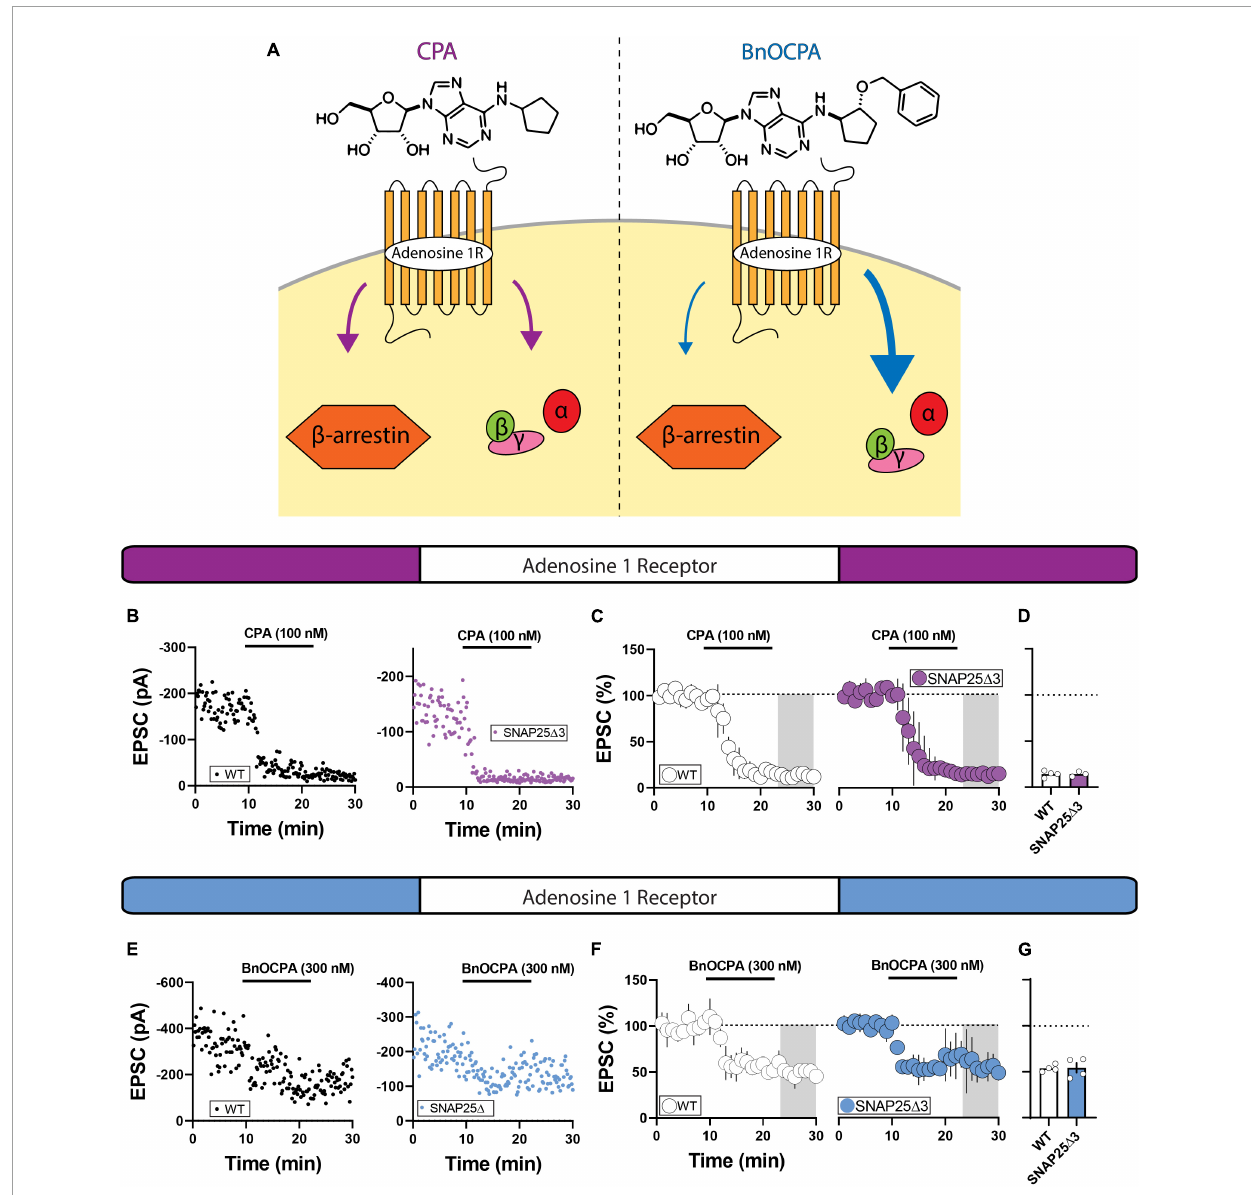
FIGURE4 Using a biased agonist of the adenosine A1 receptor to preferentially engage G-protein signaling. (A) The biased adenosine A1 receptor BnOCPA preferentially stimulates G-protein signaling. (B) Representative experiments showcasing amplitude peaks of EPSCs following bath application adenosine 1 receptor agonist CPA (CPA final concentration = 101 nM) collected from WT and SNAP25 (cid:49) 3 mice. (C) Percentage changes in EPSC peak amplitude with regards to baseline following CPA application (application time: 10–20 min). (D) Summary of average EPSC percentages following application of the full adenosine A1 receptor agonist CPA (WT: mean = 14.26 ± 1.72%; SNAP25 (cid:49) 3: mean = 14.23 ± 1.62%; p = 0.9907) [WT: n = 4 cells, N = 3 animals; SNAP25 (cid:49) 3: n = 3 cells, N = 3 animals]. (E) Representative experiments showcasing amplitude peaks of EPSCs following bath application adenosine 1 receptor agonist CPA (CPA final concentration = 101 nM) collected from WT and SNAP25 (cid:49) 3 mice. (F) Percentage changes in EPSC peak amplitude with regards to baseline following CPA application (application time: 10–20 min). (G) Summary of average EPSC percentages following application of the biased adenosine A1 receptor agonist BnOCPA (WT: mean = 51.34 ± 2.30%; SNAP25 (cid:49) 3: mean = 49.95 ± 7.02%; p = 0.8569). [WT: n = 4 cells; SNAP25 (cid:49) 3: n = 4 cells). Gray box indicates 5-min bin for comparative analysis. Error bars indicate SEM. Student’s unpaired, two-tailed, t